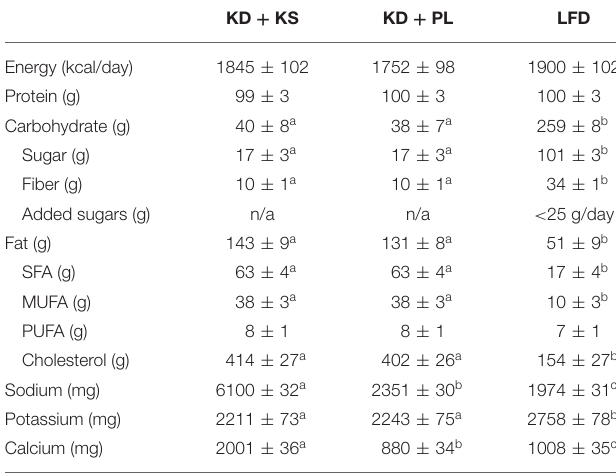
TABLE 2 | Diet composition.